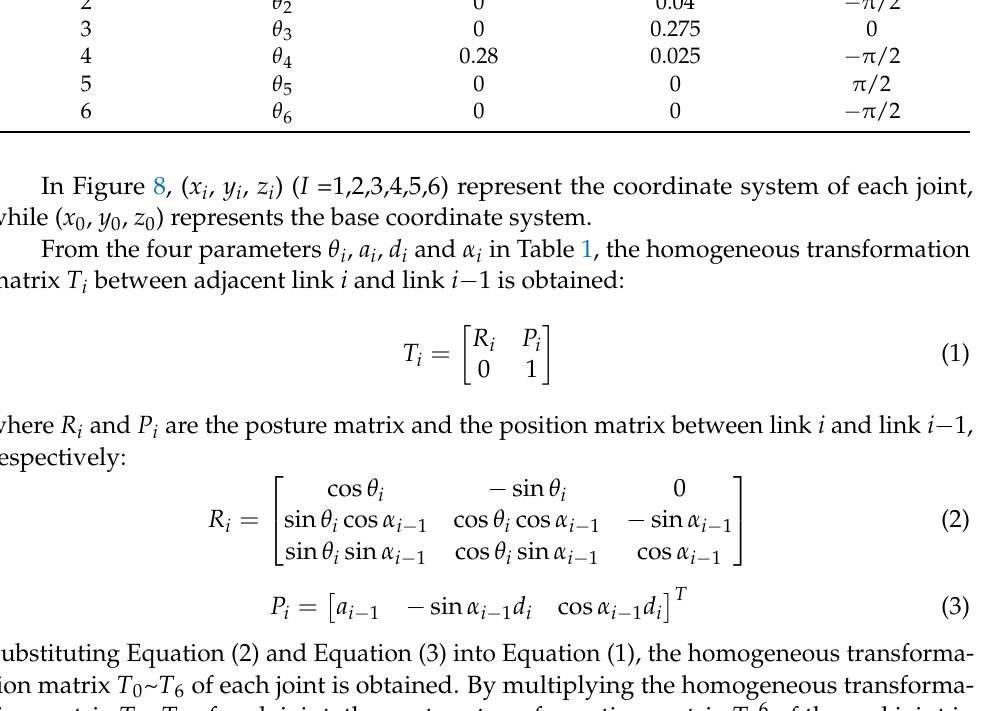
Table 1. D-H parameters.